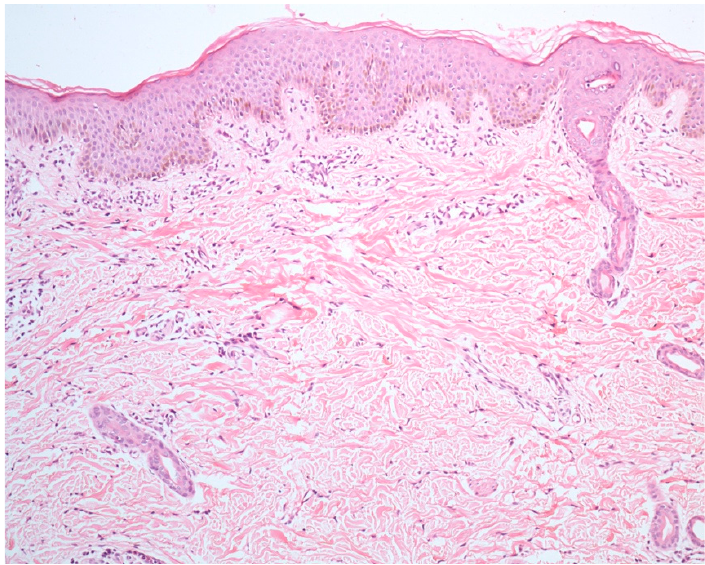
Figure 4. Viral exanthem showing normal epidermis with sparse perivascular infiltration of lymphocytes and occasional eosinophils (H&E ×40).